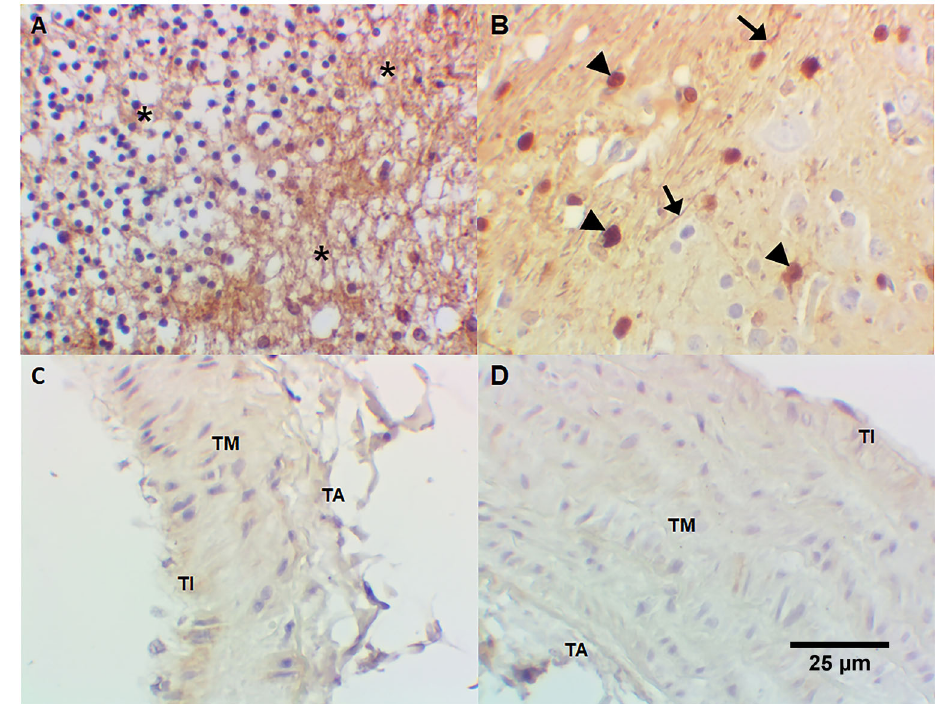
Figure 8. Detection of S-100 protein (neural/neuronal markers) by immunohistochemistry: A , diffuse positivity for S-100 protein in human cerebellum neuropil (*); B , S-100 protein positivity in Callithrix spp. central nervous system (glial nuclei [arrowhead] and glial fi bers [black arrow] are positive); C , absence of S-100 protein in tunica intima (TI), media (TM), and adventitia (TA) of Callithrix spp. pulmonary artery; D , absence of S-100 protein in Callithrix spp. aorta (both tunicae intima and media are negative). Immunoperoxidase, 400 (cid:3) (original magni fi cation), scale bar 25 m